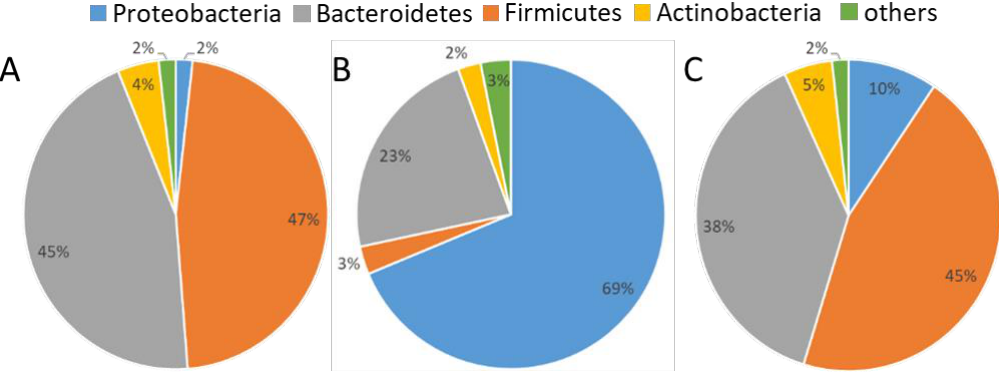
Figure 3. Relative abundances of phyla in samples. Pie chart percentages are averages of all samples